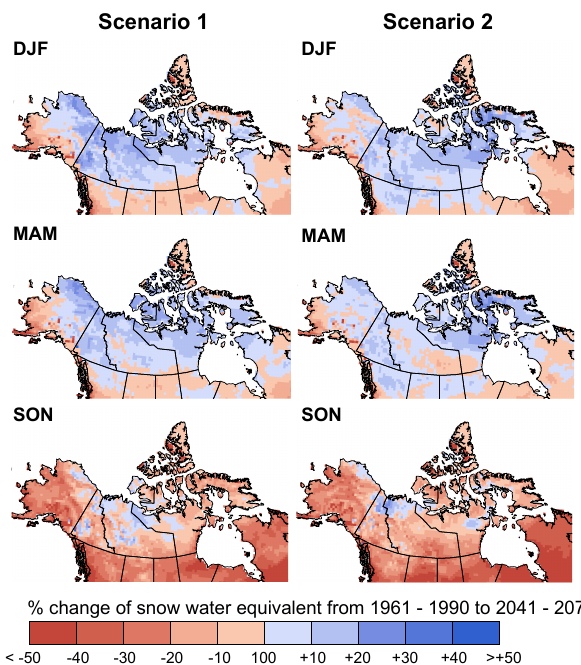
Fig. 9b. Change in snow water equivalent from 1961–1990 mean to 2041–2070 mean from the CRCM data displayed by season Winter (December, January, February), Spring (March, April, May) and Fall (September, October,